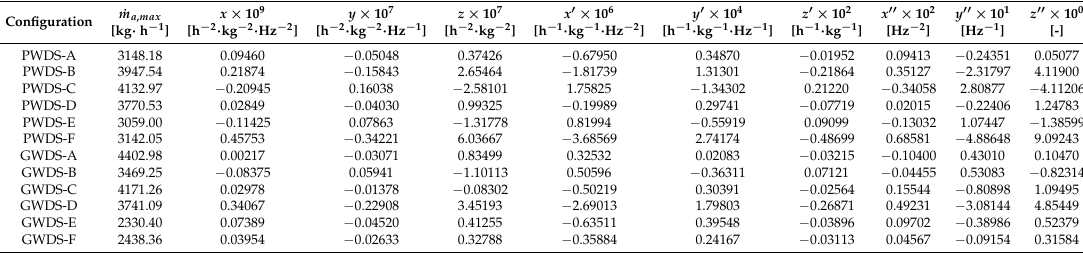
Table 2. Constants for Equation